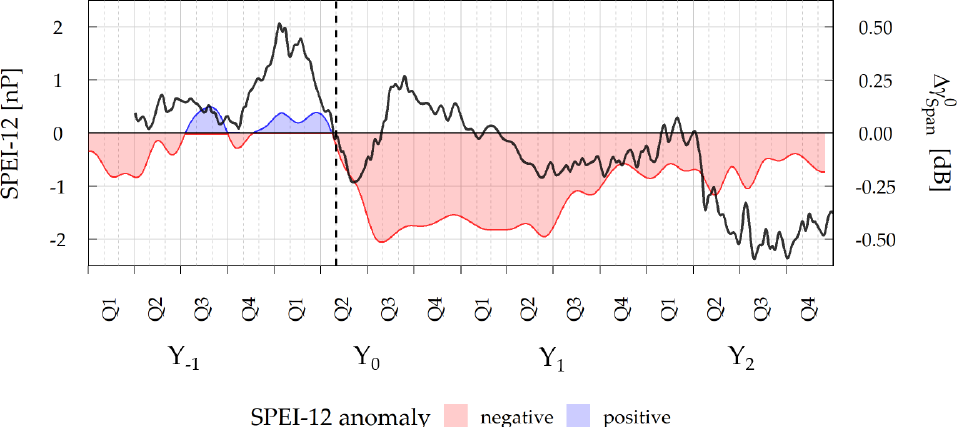
Figure 9. Temporal evolution of the S-1 span difference between unaffected and affected/damaged tree canopies ( ∆ γ 0 ) in concurrence with the drought index SPEI. SAR data processed with temporal Span ENL =